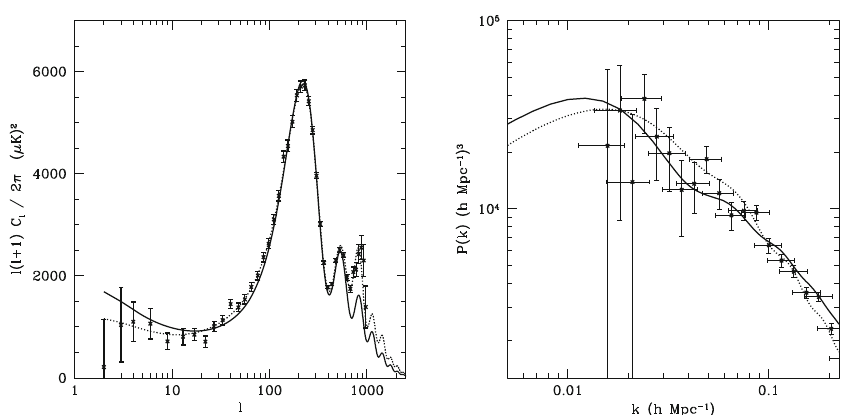
Fig. 4 Left: the cosmic microwave background angular power spectrum l ( l + 1 ) C l /( 2 π) for TeVeS (solid) and Λ CDM (dotted) with WMAP 5-year data (Nolta et al. 2009). Right: the matter power spectrum P ( k ) for TeVeS (solid) and Λ CDM (dotted) plotted with SDSS